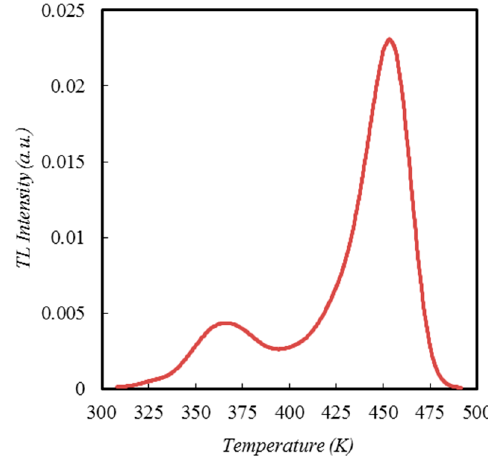
Figure 5. TL glow curve of X-ray irradiated KCl:Eu 2+ (0.02 mol%) single crystals.